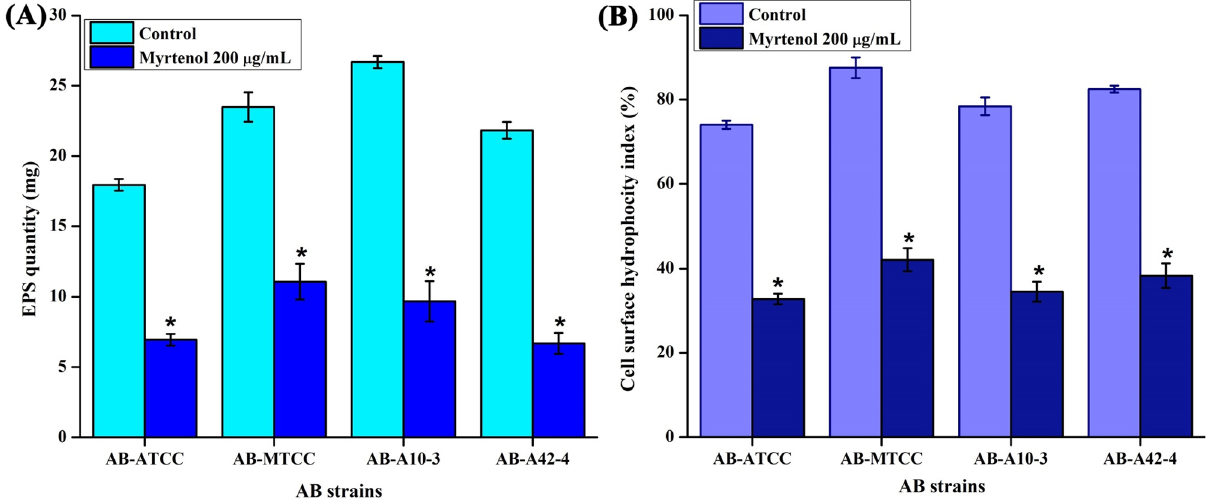
Figure 5. Inhibitory effect of myrtenol (200 μg/mL) on ( A ) EPS production and ( B ) CSH of AB-ATCC 19606, AB-MTCC 9826, AB-A10-3 and AB-A42-4. Error bars and asterisks indicate the SD and statistical significance ( p < 0.05),